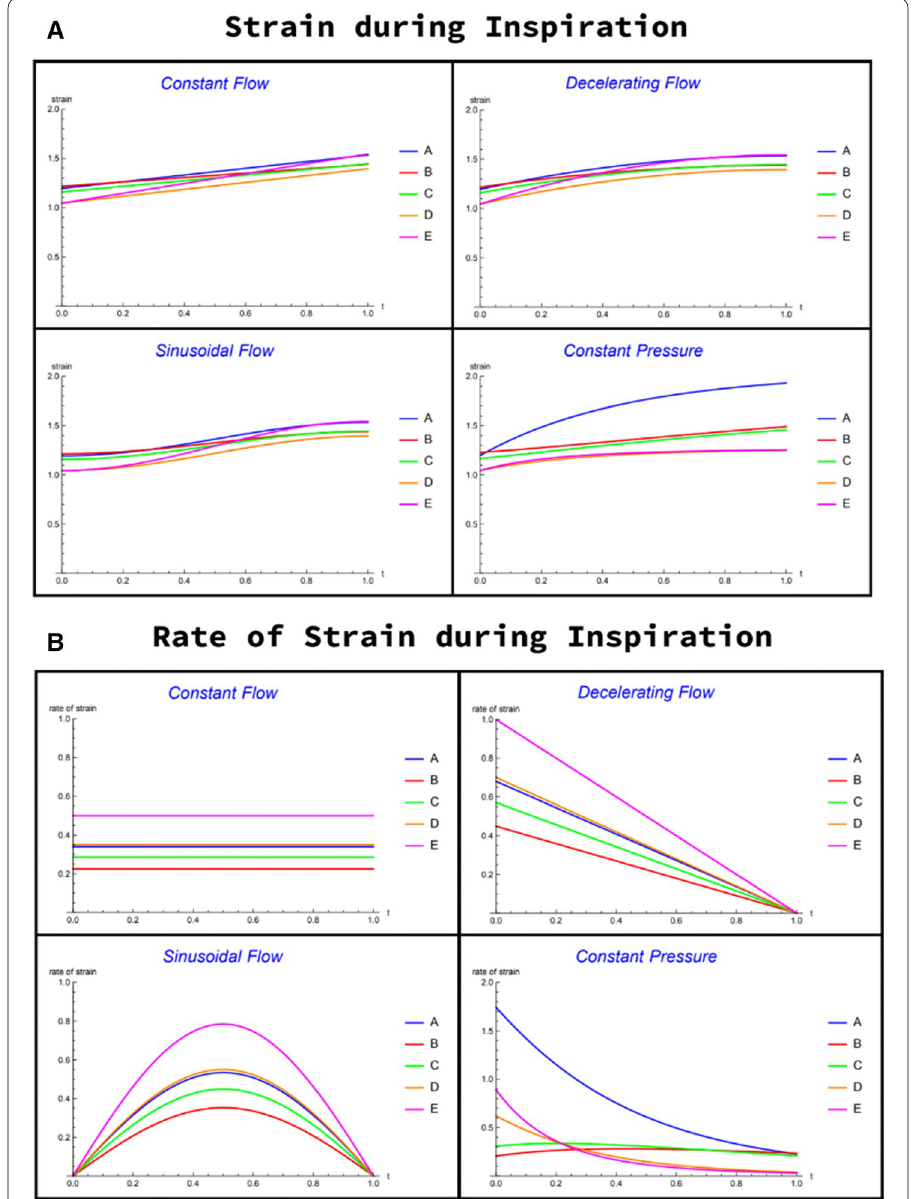
Fig. 4 Compartmental strain ( A ) and strain rate ( B ) for all controlled flow and constant pressure ventilation modes. Note the marked differences among compartments, depending on flow